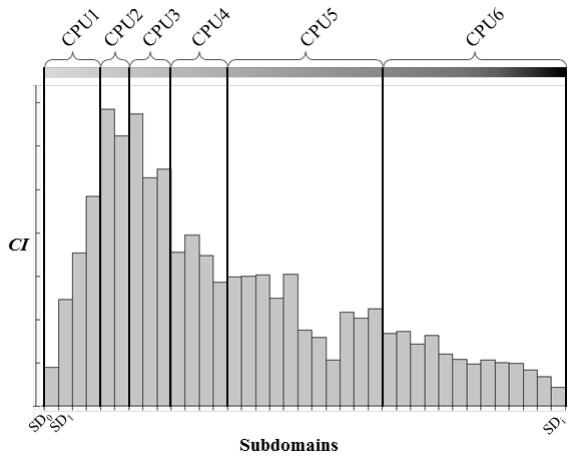
Figure 3: Conceptual illustration of load balancing. The cumulative computational intensity CI is evenly distributed among processors by assigning a varying number of